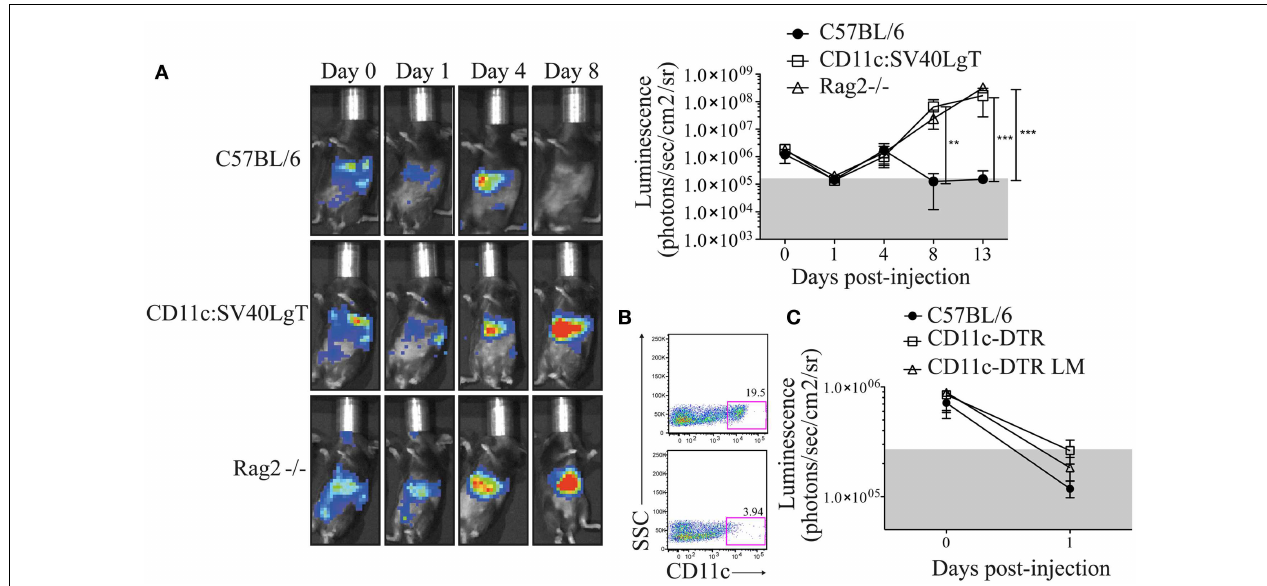
littermates (upper panel) and CD11c-eGFP-DTR mice (bottom panel) were injected with DT and the efficiency of the depletion of CD11c + cells was checked in the spleen 24h later by flow cytometry (gated on single CD3 - CD19 - cells). (C) Luc-DC were transferred into C57BL/6 ( n = 7), DT-treated CD11c-eGFP-DTR ( n = 8), and DT-treated CD11c-eGFP-DTR littermates ( n = 7) mice. CD11c-eGFP-DTR mice were treated with the DT, 1day prior the transfer of the Luc-DC.The tumor growth was assessed just after the transfer and at day 1. Data are presented as mean ± SD.The p values were determined by a two-way ANOVA with Bonferroni